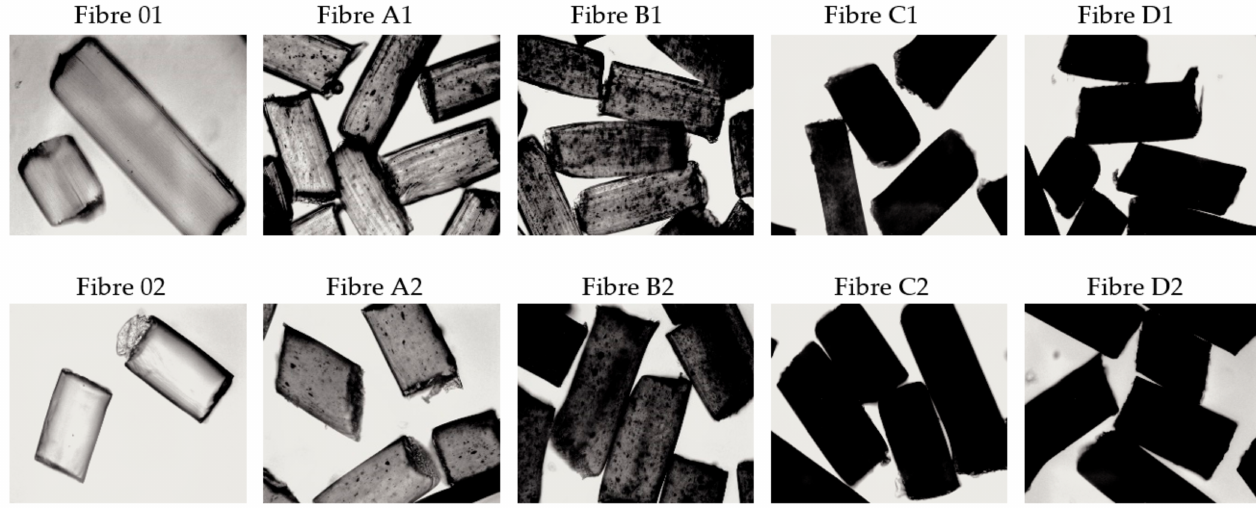
Figure 3. Optical microscope images of the surfaces of fibres that were coagulated in water (1) and in methanol (2) (10 ×